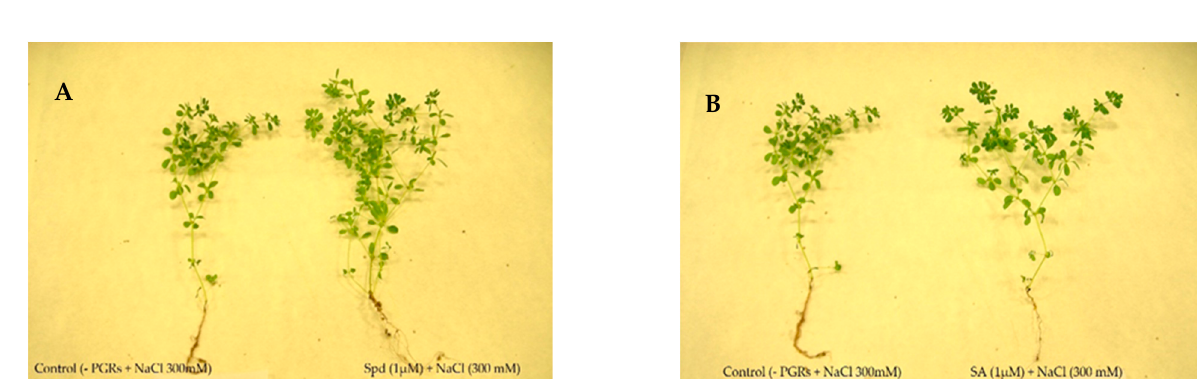
Figure 1. Frankenia pulverulenta cultivated with Spd + salt compared to control ( A ), and F. pulverulenta cultivated with SA + salt compared to control ( B ).